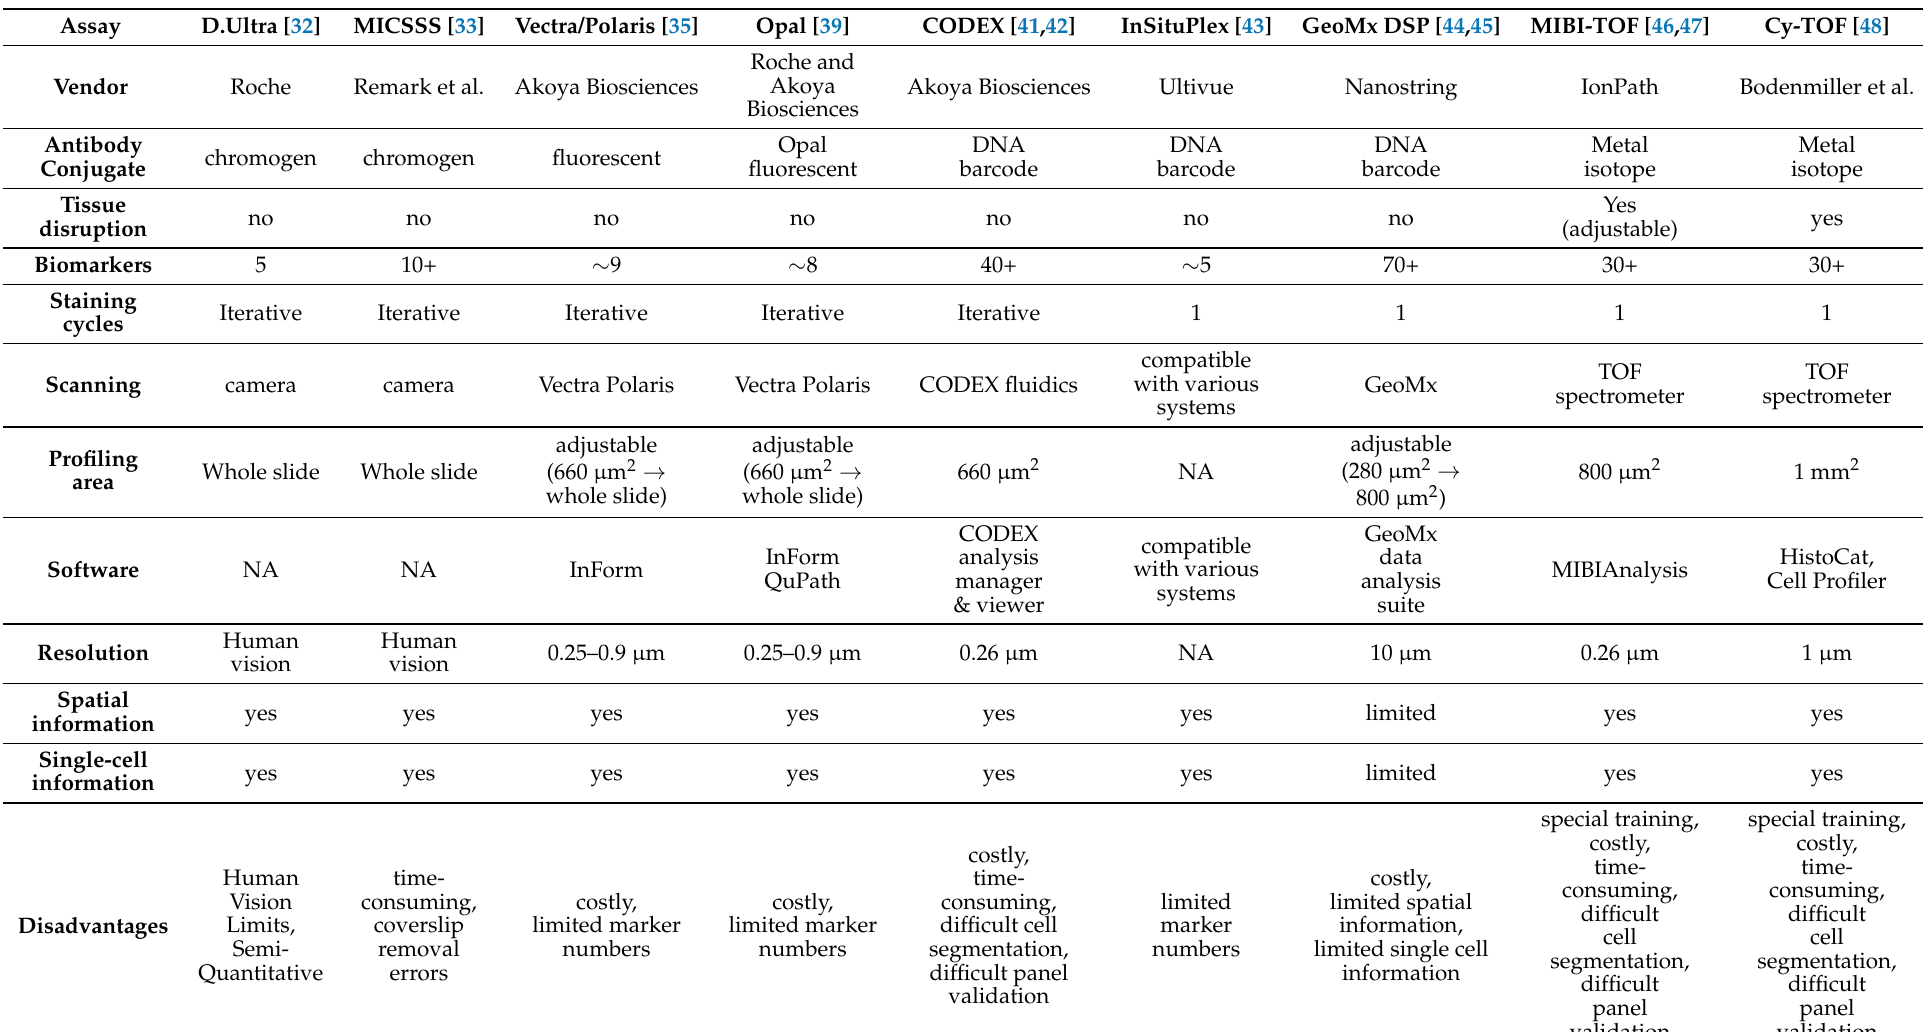
Table 1. Differences and comparisons of the various characteristics among the different multiplex platforms and